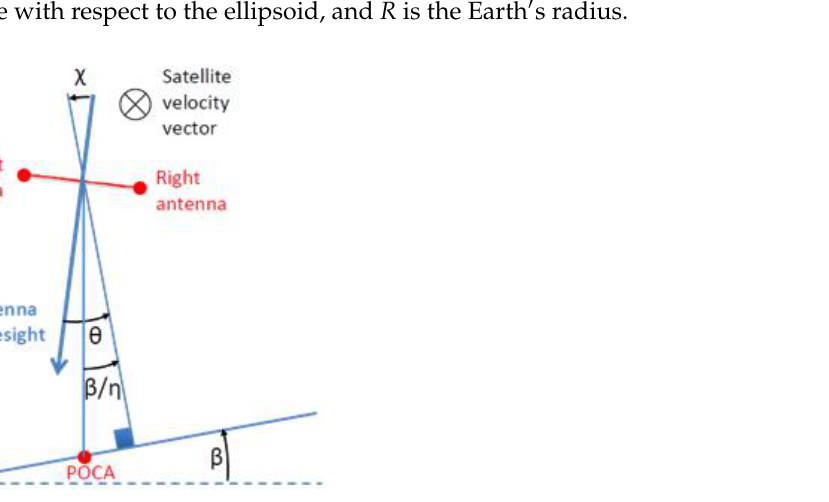
Figure 2. Roll campaigns: acquisition geometry in the across-track plane (angles exaggerated for clarity). β represents the ocean across the track slope and χ the platform roll angle. Figure taken from [9].